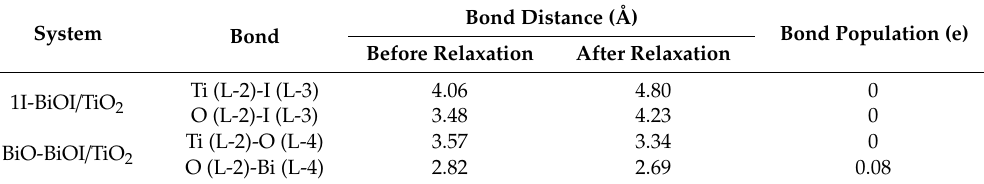
Table 1. The calculated bond distance (Å) and bond population (e) for the atoms at the interface of the BiOI / TiO 2